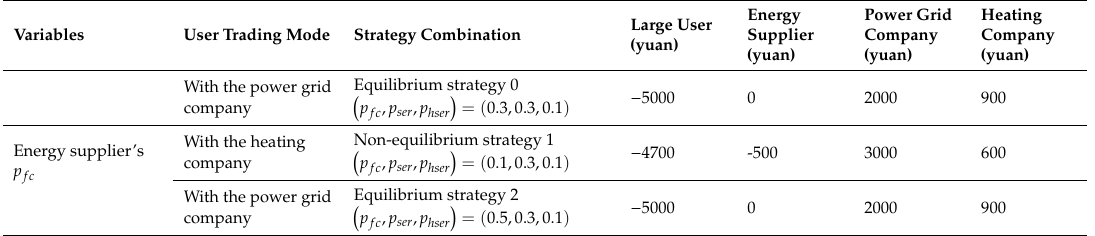
Table 2. Strategy combination and game payo ff s for the market participants in the above